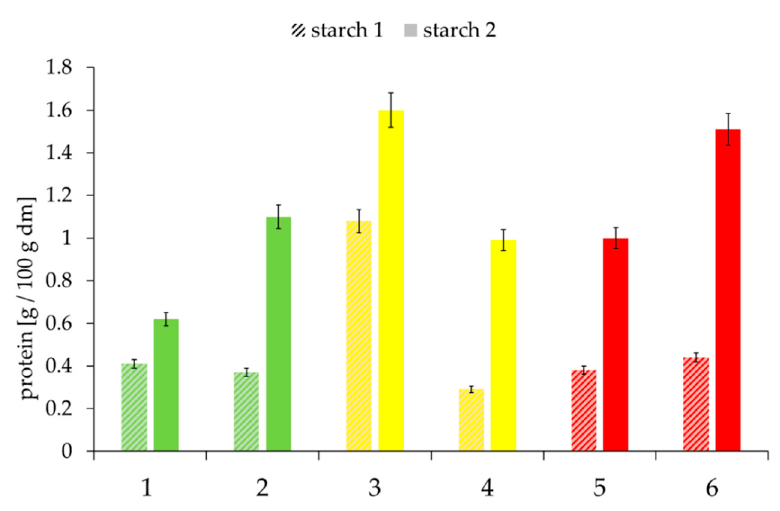
Figure 5. Protein content of the starch phases of the selected samples, depending on “good” to “medium” to “poor” baking quality and the falling number (FN) within the individual baking quality classes (here: first samples were always assigned the lower FN and second samples the higher FN). Sample description: see Table 1. Bars represent the mean value of two replicates; error bars represent the confidence